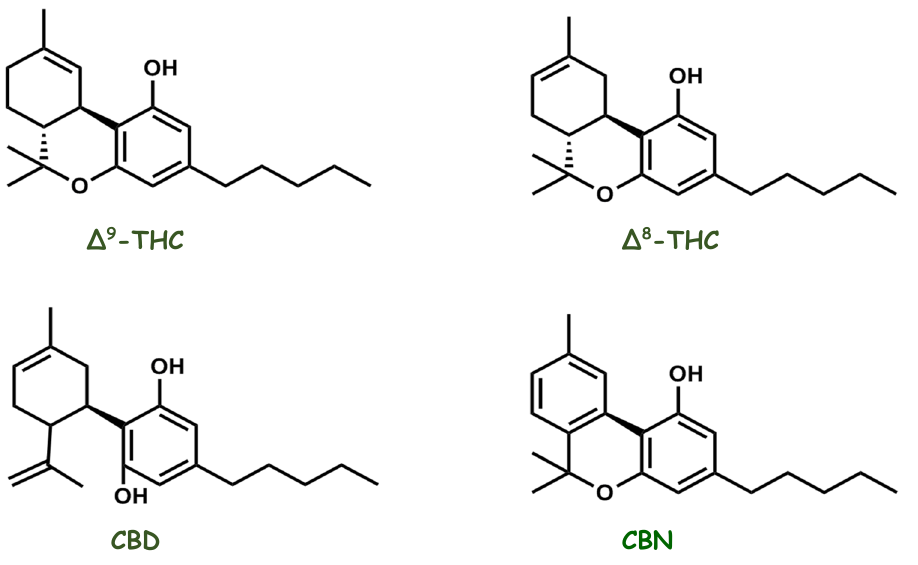
Figure 6. Chemical structures of the main pharmacologically active cannabinoid compounds isolated from Cannabis sativa .